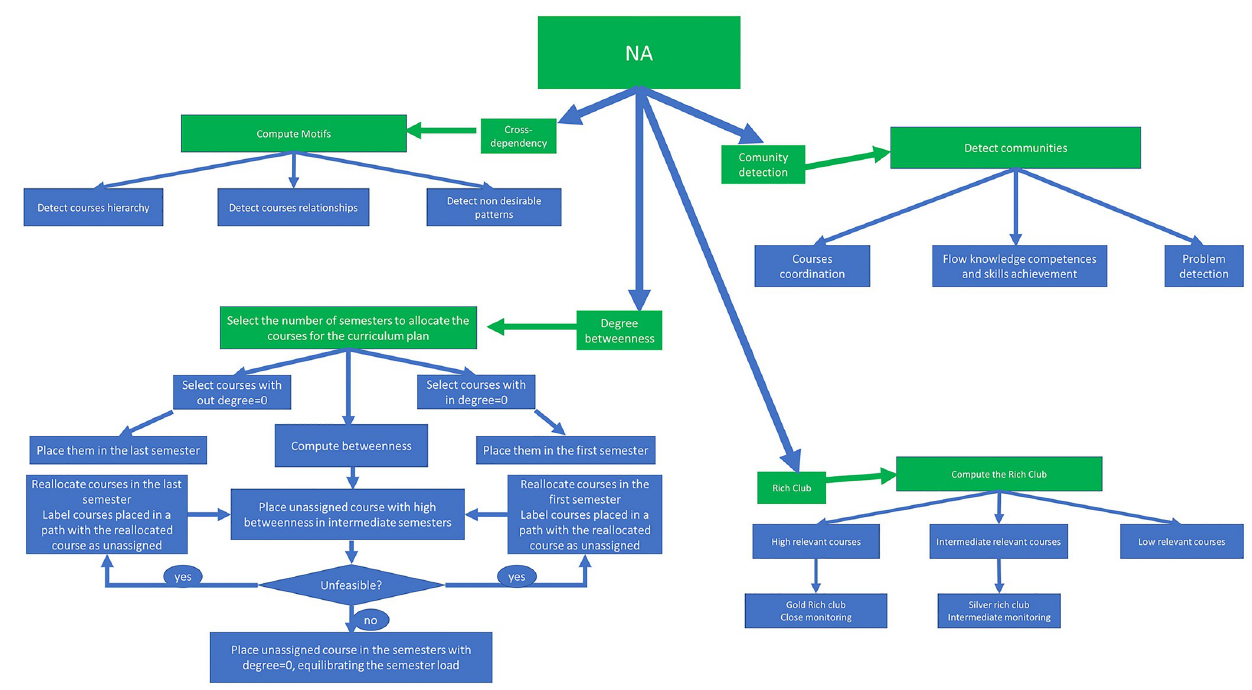
Fig 3. NA applications to curriculum